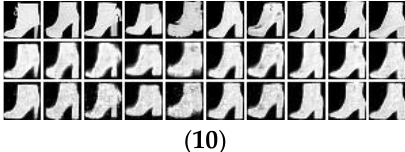
Figure 22. Reconstruction images on the FMNIST data set. For each subfigure, the top row demonstrates the original images, the middle row demonstrates the recovery images of AE, and the bottom row demonstrates the recovery images of RCDAE.